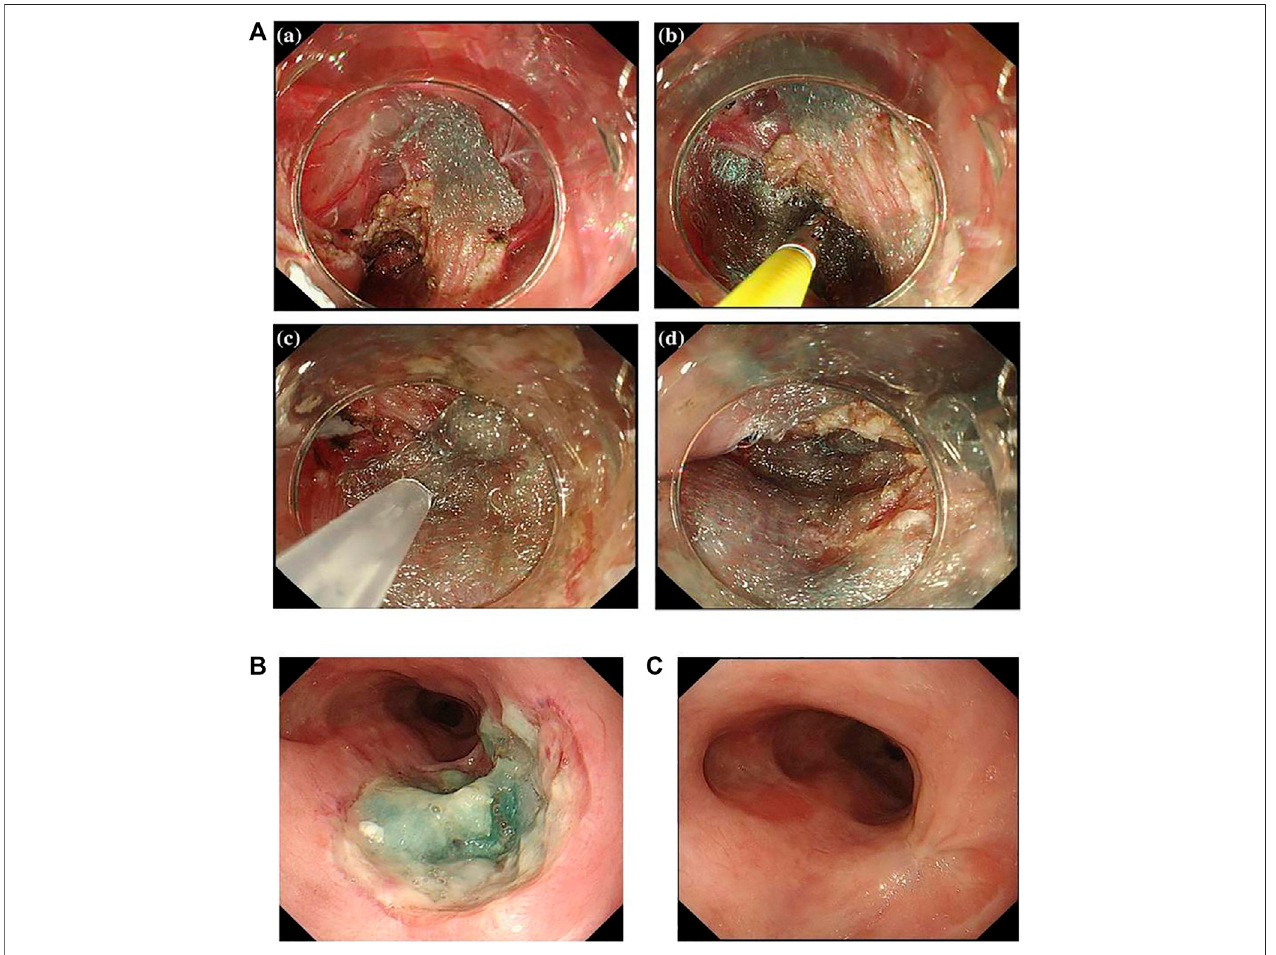
FIGURE3| Newlyproposedhealingdressingsbasedonbiocompatiblebiomedicalpolymers. (A) EsophagealperforationwascompletelycoveredbyPGAsheets. (B) The endoscopic image of the esophageal perforation with PGA sheets after 6 days of ESD. (C) The endoscopic image of the esophagus after 3 months of ESD. Reproduced from Seehawong et al. (2019). Copyright (2019), with permission from Springer Nature.